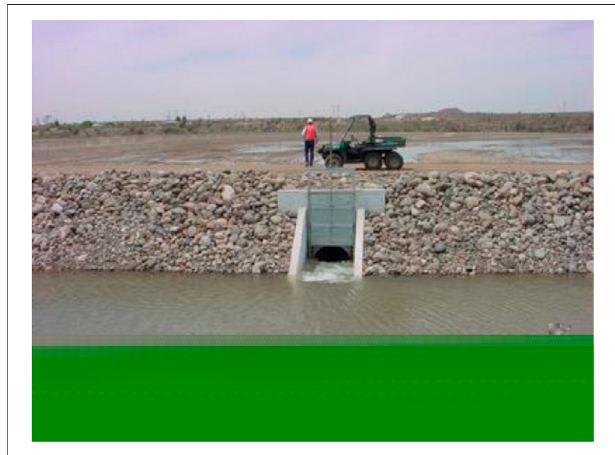
FIGURE 8 | Percolation pond – arti fi cial recharge technique. Source: DFID, 2005.